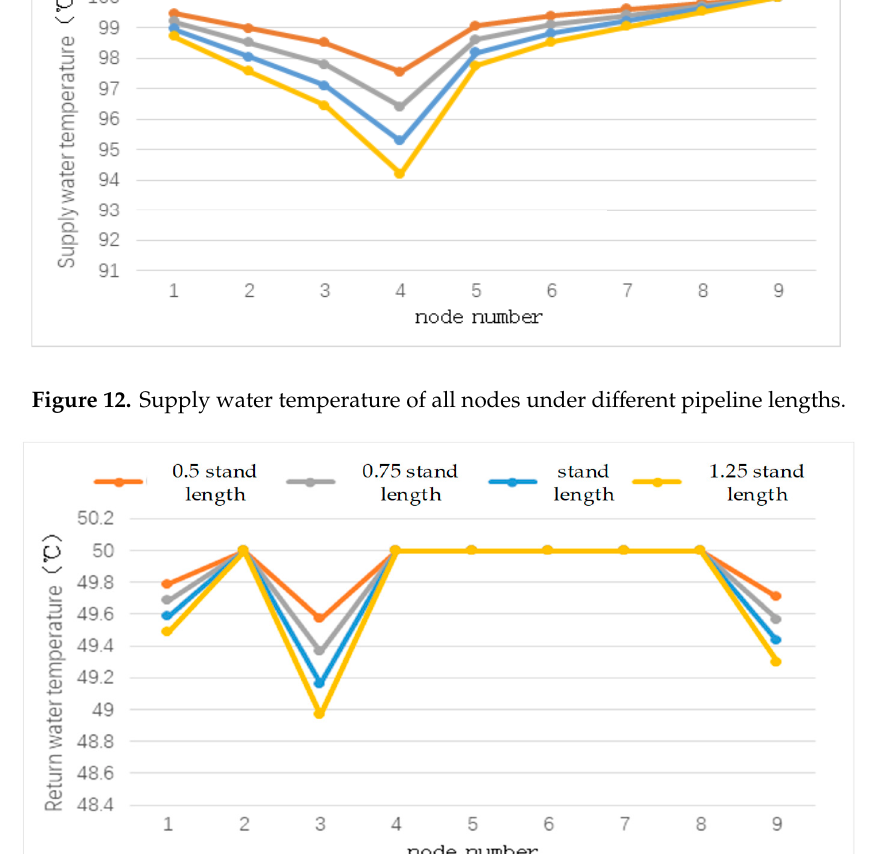
Figure 13. Return water temperature of all nodes under different pipeline lengths.